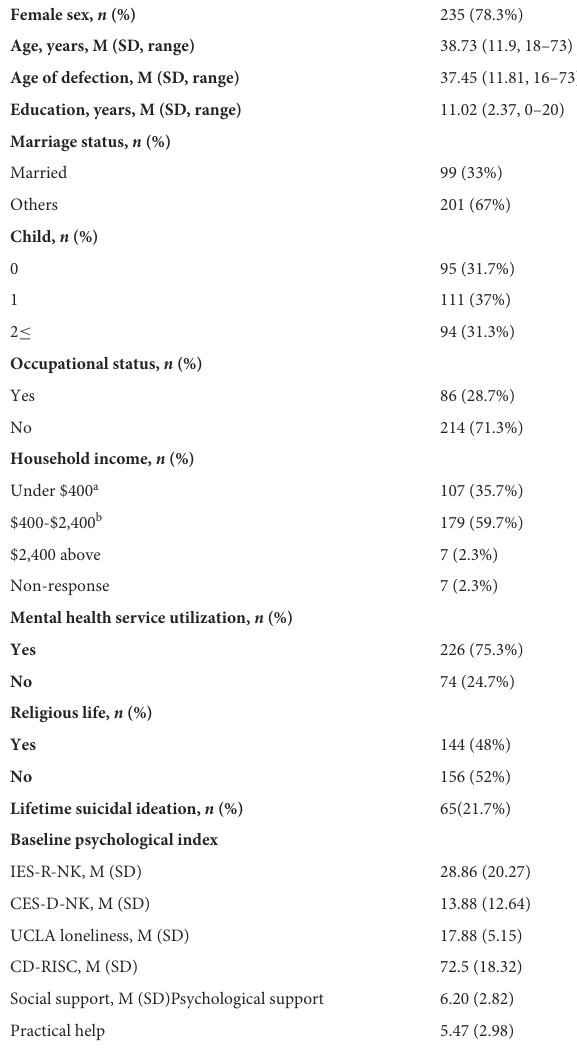
TABLE 1 Sociodemographic and psychological factors of participants at